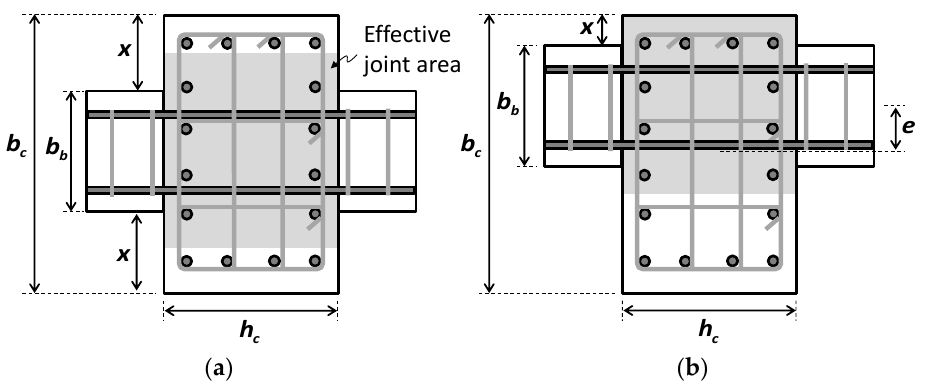
Figure 1. Effective joint area: ( a ) concentric beam–column joint; ( b ) eccentric beam–column joint.